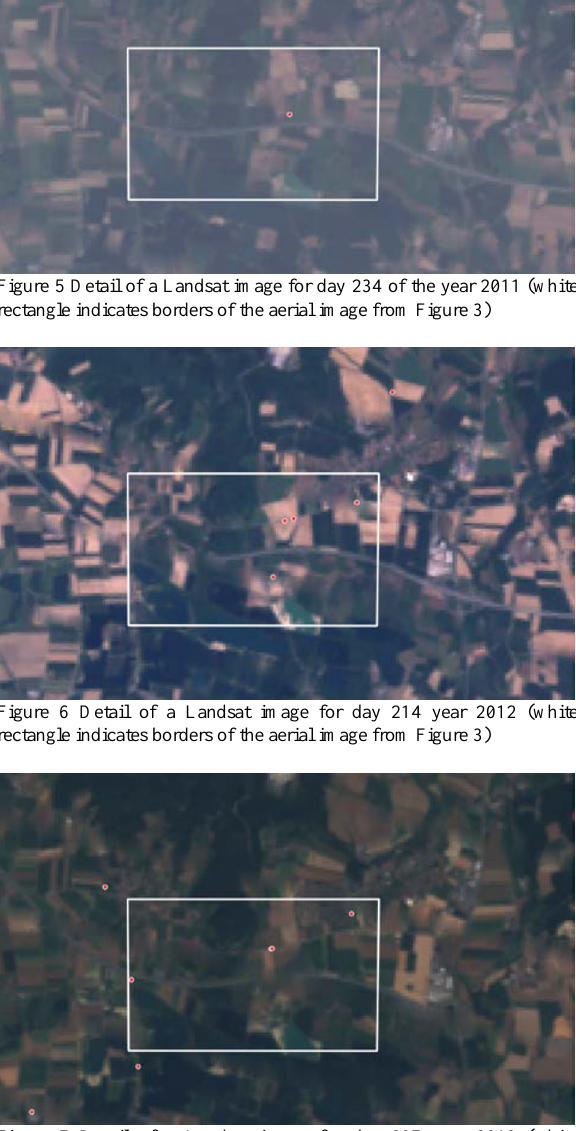
Figure 7 Detail of a Landsat image for day 207 year 2013 (white rectangle indicates borders of the aerial image from Figure 3) Figure 4 Seasonal and day time distribution of WVC for bird of prey and wild boar In one year (2013) the distribution of WVC is wide spread, Having a closer look at the distribution of WVC with regard to which may be related to vegetation periods and individual crops land use pattern, in the given project region land use and or plants (Figure 9, Figure 10, Figure 11). The majority of vegetation is strongly influenced by agriculture, resulting in not accidents occur during spring, summer and autumn period in only seasonal differences, but also significant annual changes the agricultural areas, while winter accidents are located around due to crop rotation. An analysis of three Landsat scenes for the years 2011, day 234 (Figure 5), 2012, day 214 (Figure 6) and 2013, day 207 (Figure 9) show the same area during the main vegetation period of most farm cultures in late July and early August.